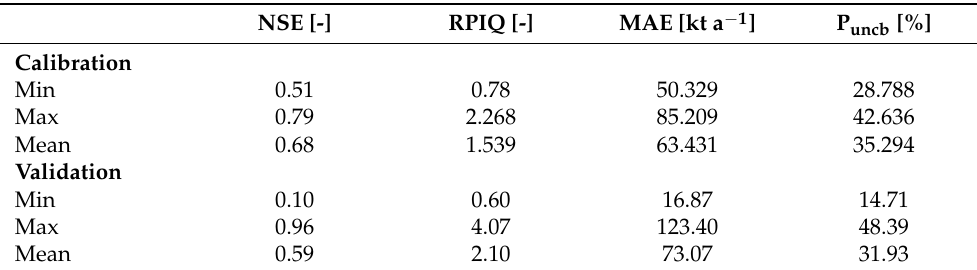
Table 3. Statistics of objective functions obtained during 5- fold cross validation: Nash‒Sutcliffe ef- ficiency (NSE), ratio of performance to interquartile distance (RPIQ), mean absolute error (MAE) and the percentage of measurement sites where simulated values of 𝑆𝑆𝐿 𝑎 ̅̅̅̅̅̅̅ are within the uncer- tainty bounds of observed values (P uncb ).